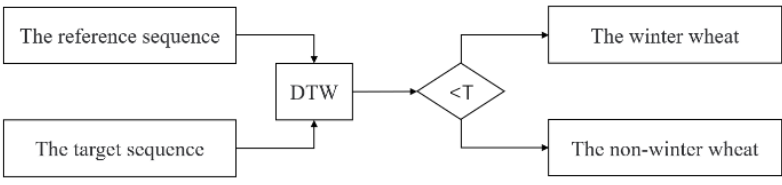
Figure 3. Dynamic time warping (DTW) algorithm.